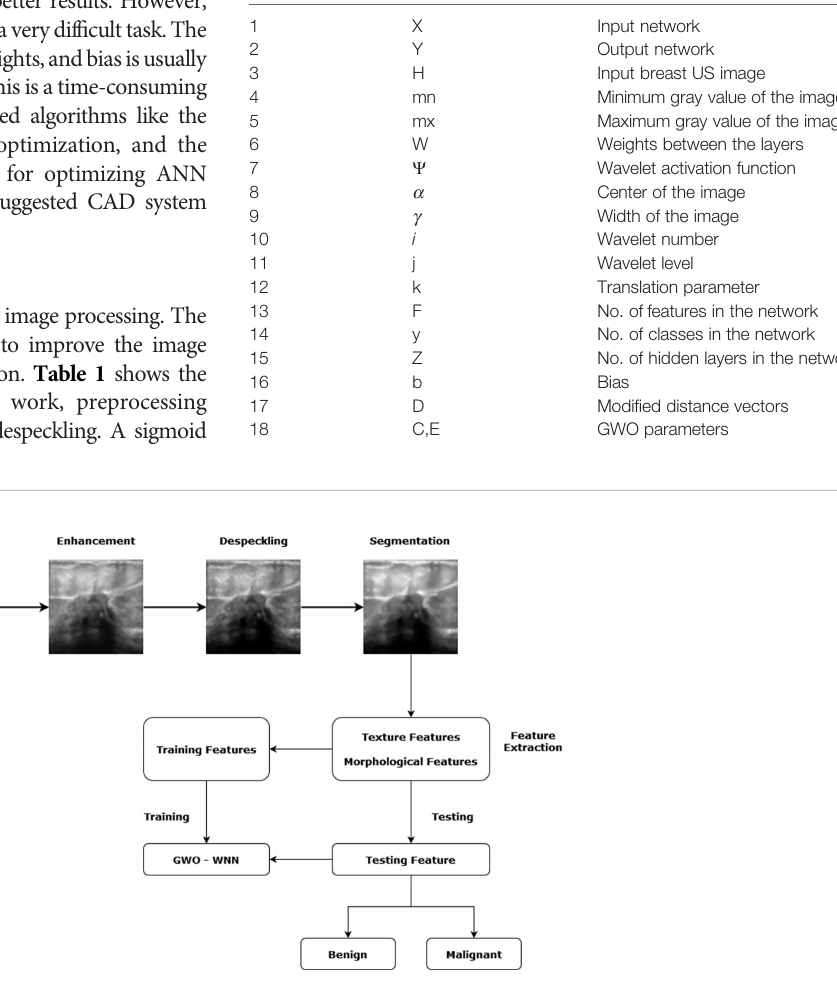
FIGURE 1 | Articulation of the Proposed CAD